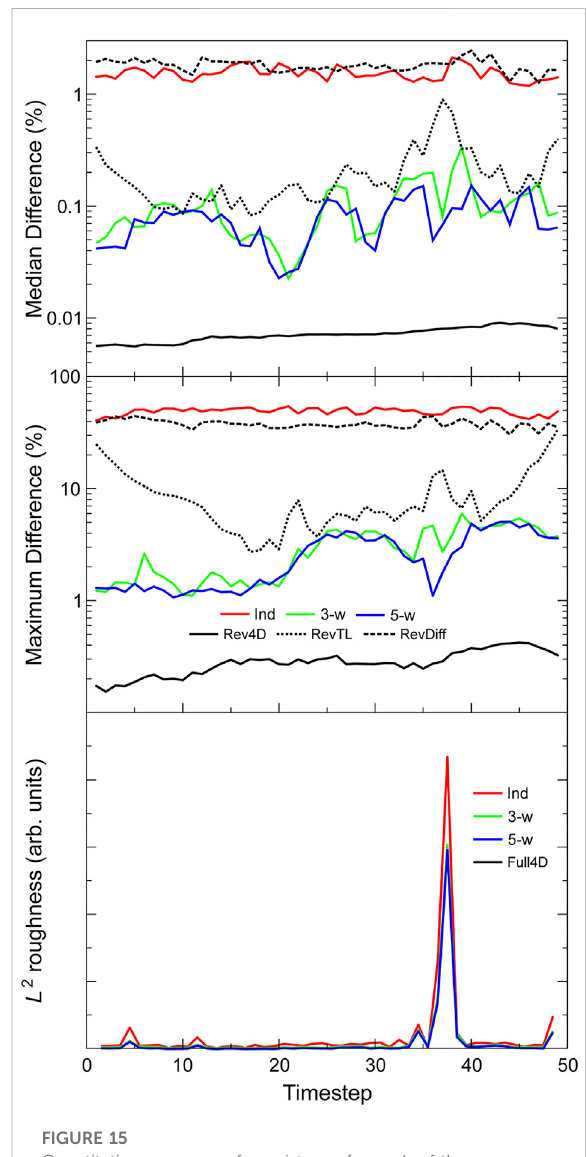
FIGURE 15 Quantitative measures of consistency for each of the inversion methods. Top: median differences between the forward full sequence 4D inversion and the independent, windowed and reverse full sequence 4D inversions, and between the forward and reverse time-lapse inversions, and between the forward and reverse difference inversions. Middle: respective maximum differences. Bottom: L 2 measures of the temporal roughness of the independent, windowed and full sequence 4D inversions (note that here the 5-w results overplot the